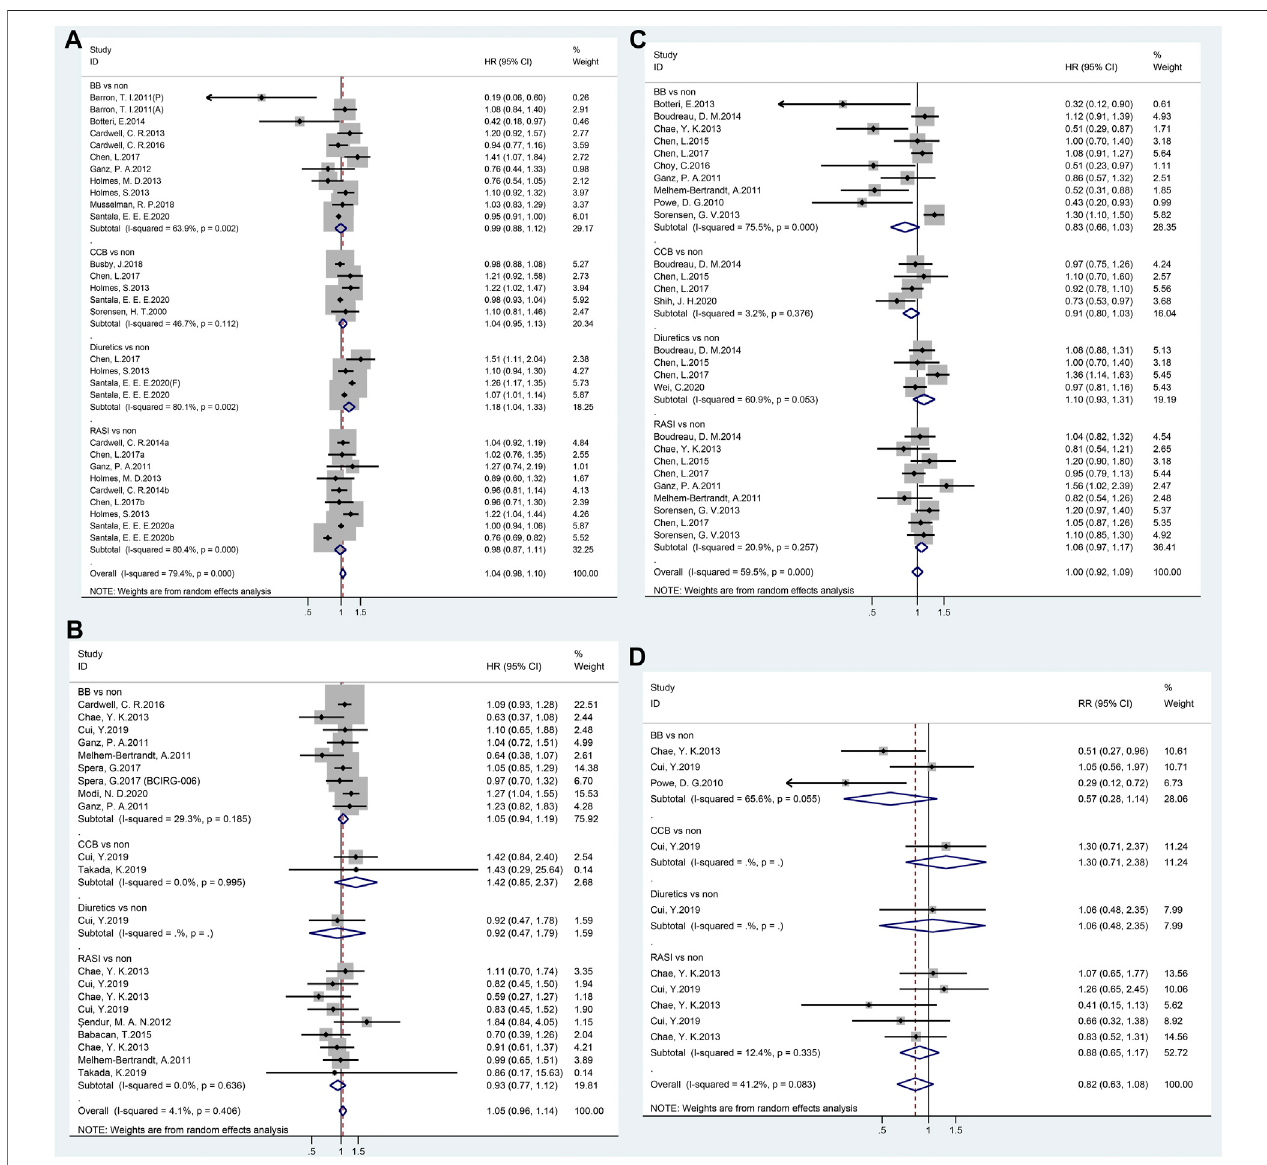
FIGURE 3 | Forest plot of studies among the prognosis of breast cancer patients with antihypertensive medications use. Legends ( A : breast cancer-speci fi c mortality; B : overall survival; C : recurrence; D : disease-speci fi c survival).